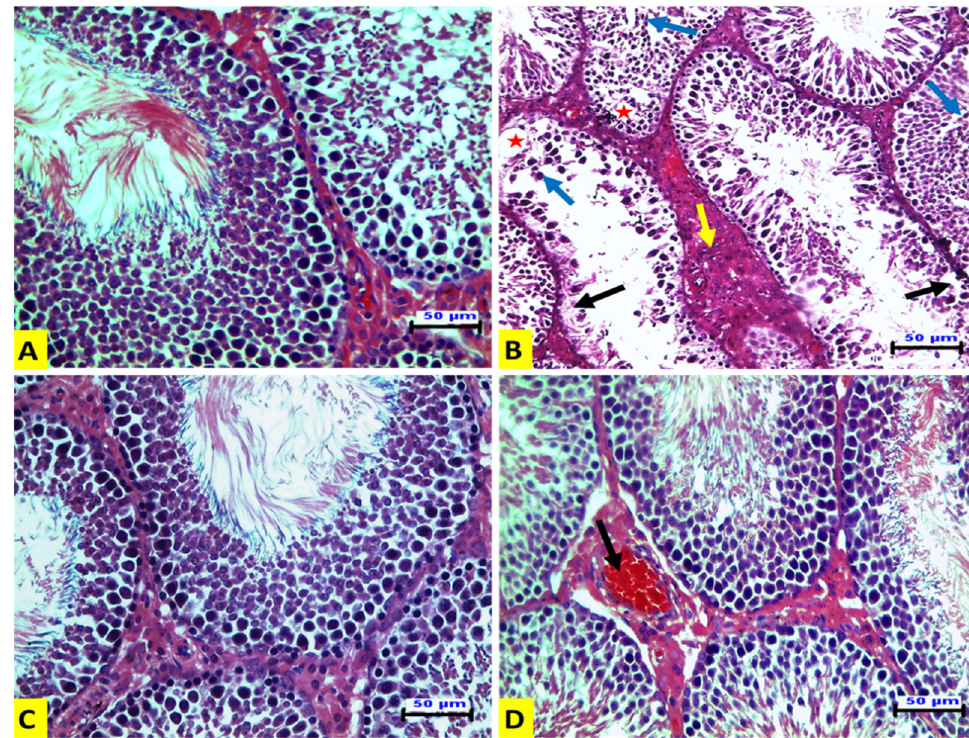
Figure 1. Representative histopathological photomicrographs of transverse sections of rat testes (hematoxylin and eosin stain X 20 , scale bar 50 μ m). ( A ) The control group has normal histologic structures of the seminiferous tubules and interstitial tissue. ( B ) The ACR-treated group has seminiferous tubules with a loss of spermatogenic epithelium leaving a denuded basement membrane (black arrow). There is also desquamated spermatogenic epithelium (blue arrow). Vacuolation in germinal layers (star) and hyperplasia of Leydig cells (yellow arrow) are also shown. ( C ) The EE-treated group shows normal histologic structures of the seminiferous tubules and interstitial tissue. ( D ) The EE + ACR group shows nearly normal seminiferous tubules and congestion of interstitial blood vessels (arrow).